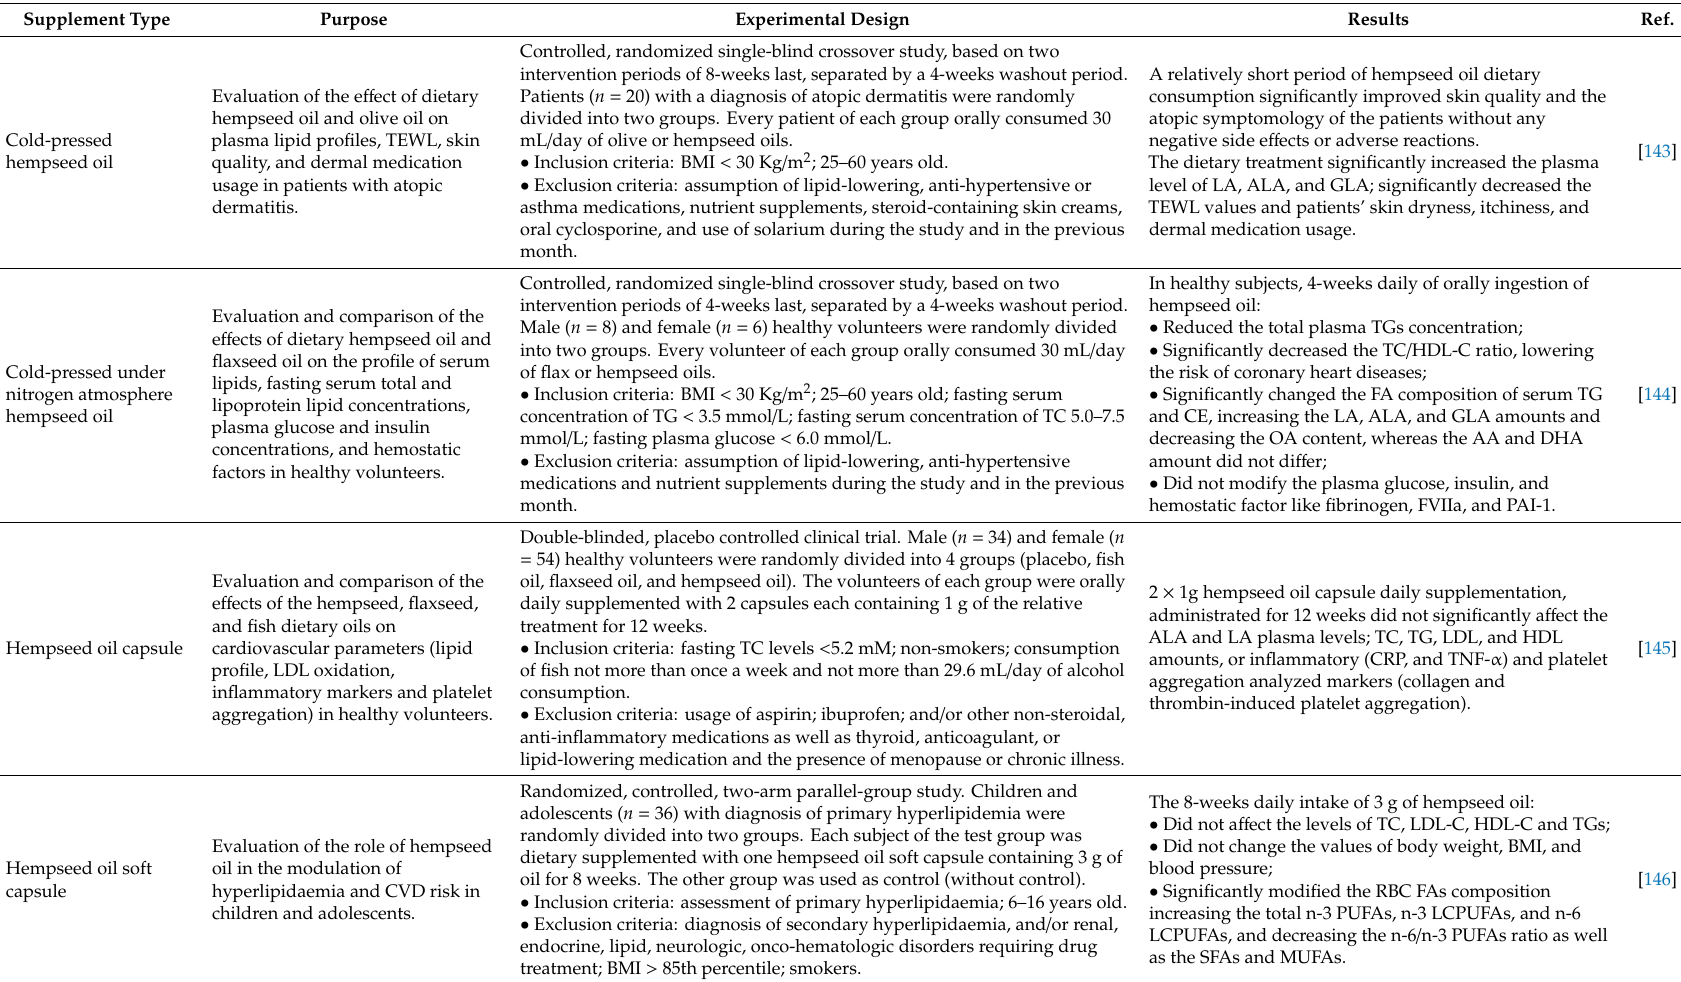
Table 12. Literature studies on the e ff ect of hempseed oil dietary supplementation on